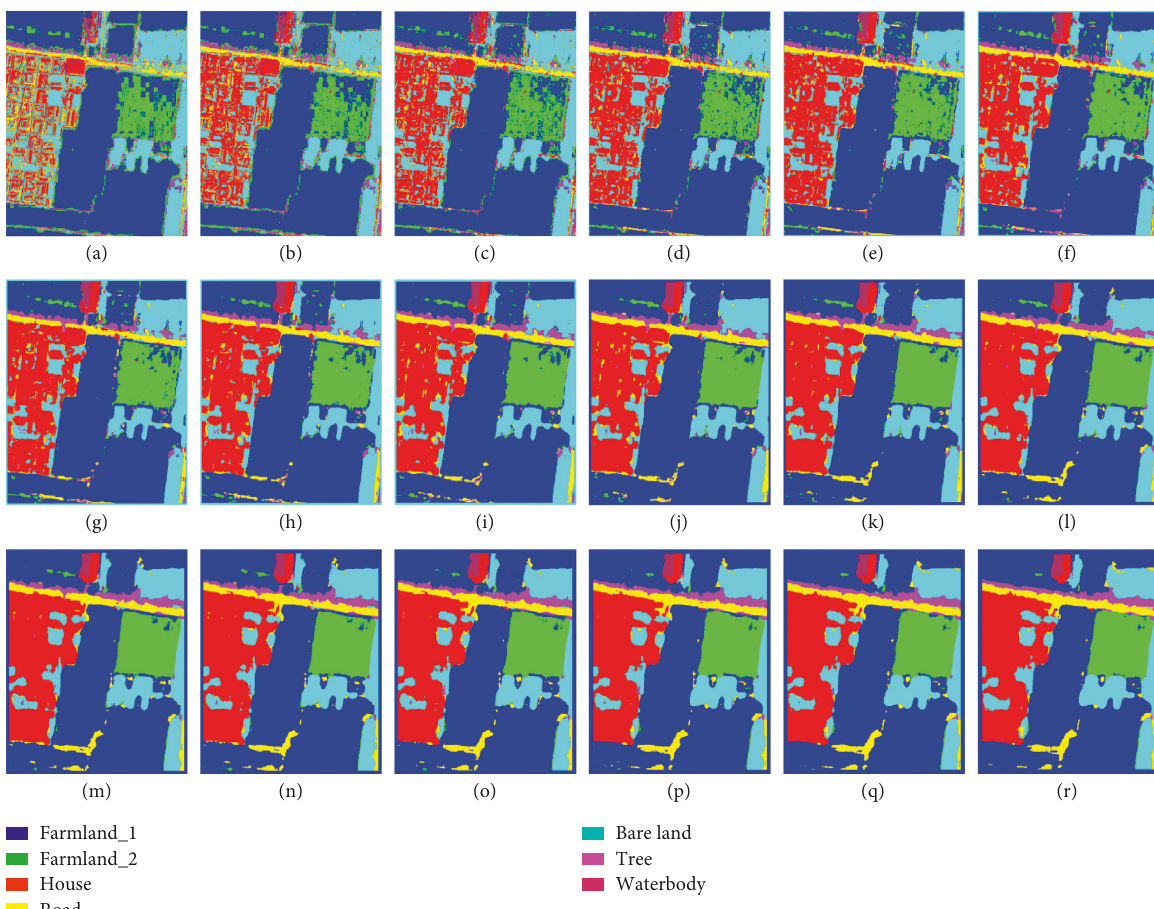
Figure 8: Series of classification results. (a) Only based on spectral features, (b) 3 × 3, (c) 5 × 5, (d) 7 × 7, (e) 9 × 9, (f) 11 × 11, (g) 13 × 13, (h) 15 × 15, (i) 17 × 17, (j) 19 × 19, (k) 21 × 21, (l) 23 × 23, (m) 25 × 25, (n) 27 × 27, (o) 29 × 29, (p) 31 × 31, (q) 33 × 33, and (r) 35 × 35.